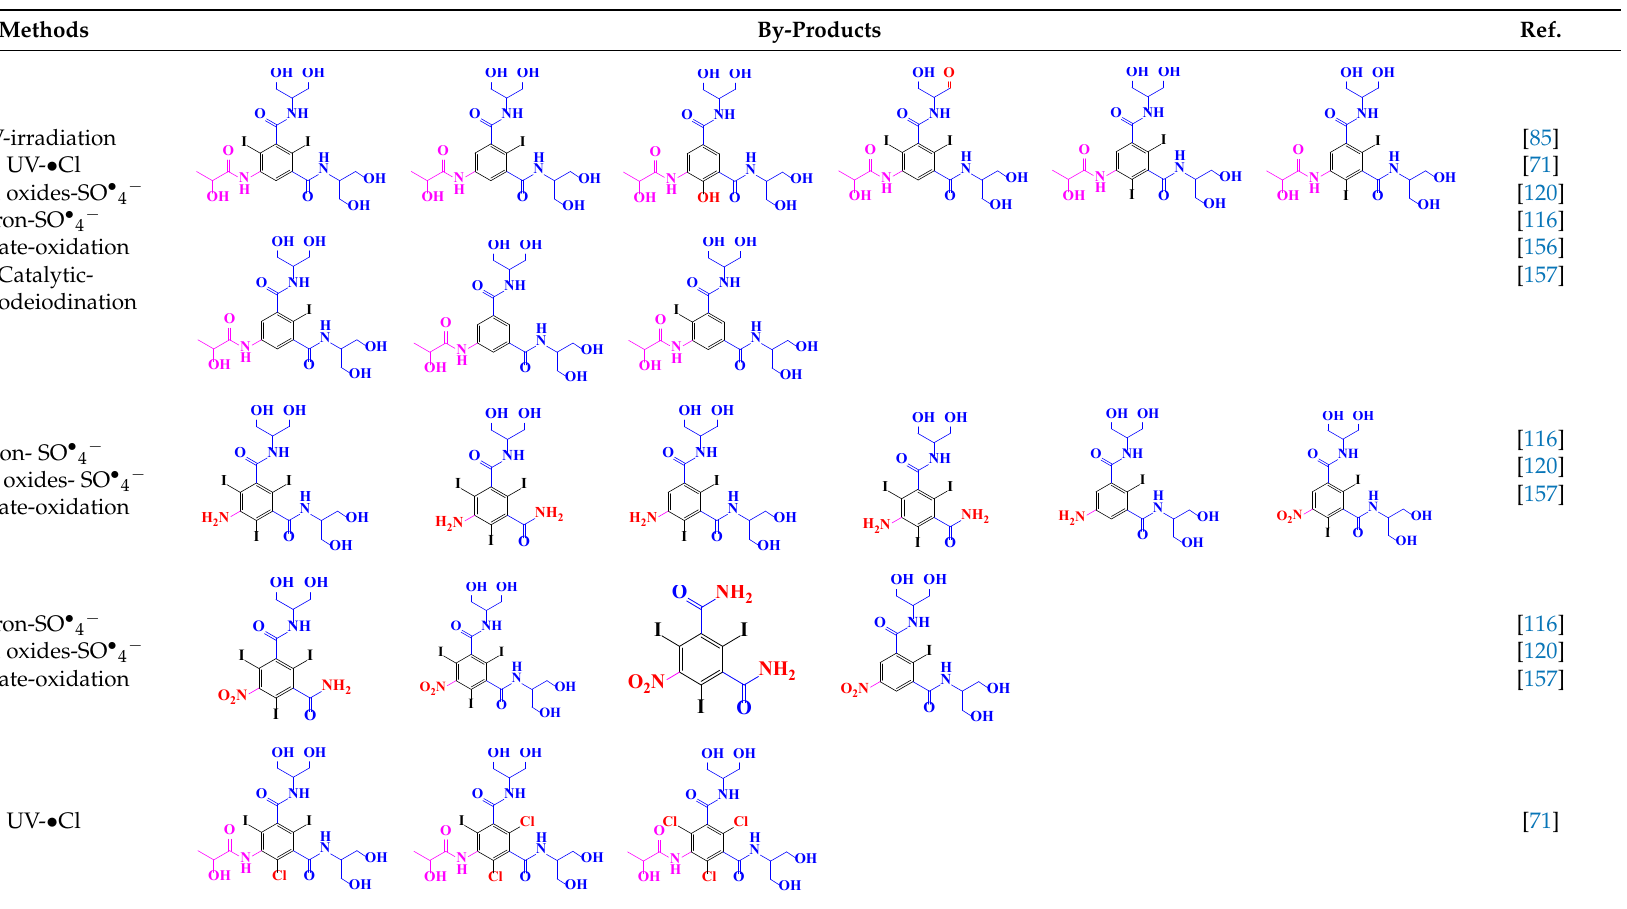
Table 8. Identified by-products of iopamidol in recent literature.